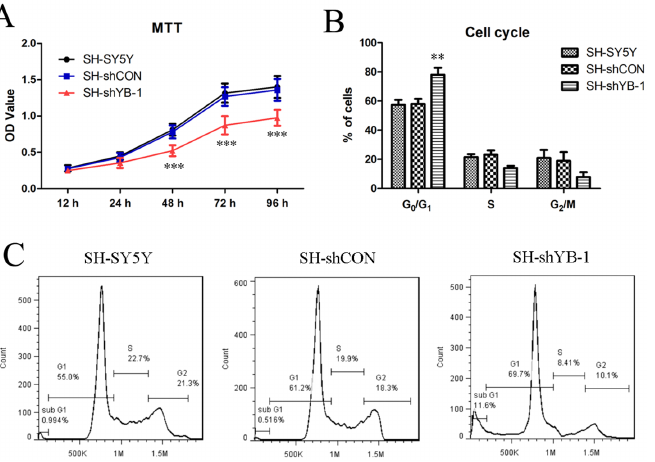
Fig 2. YB-1 silencing suppressed proliferation and induced cell cycle arrest of SH-SY5Y cells. (A) Proliferation of YB-1-silenced SH-SY5Y cells, namely SH-shYB-1, was assessed by MTT assay, in parallel with SH-SY5Y and SH-shCON as control. (B, C) The cells were fixed with 70% ethanol, stained with propidium iodide (PI), and analyzed by flow cytometry for cell cycle stages. B shows the statistical results